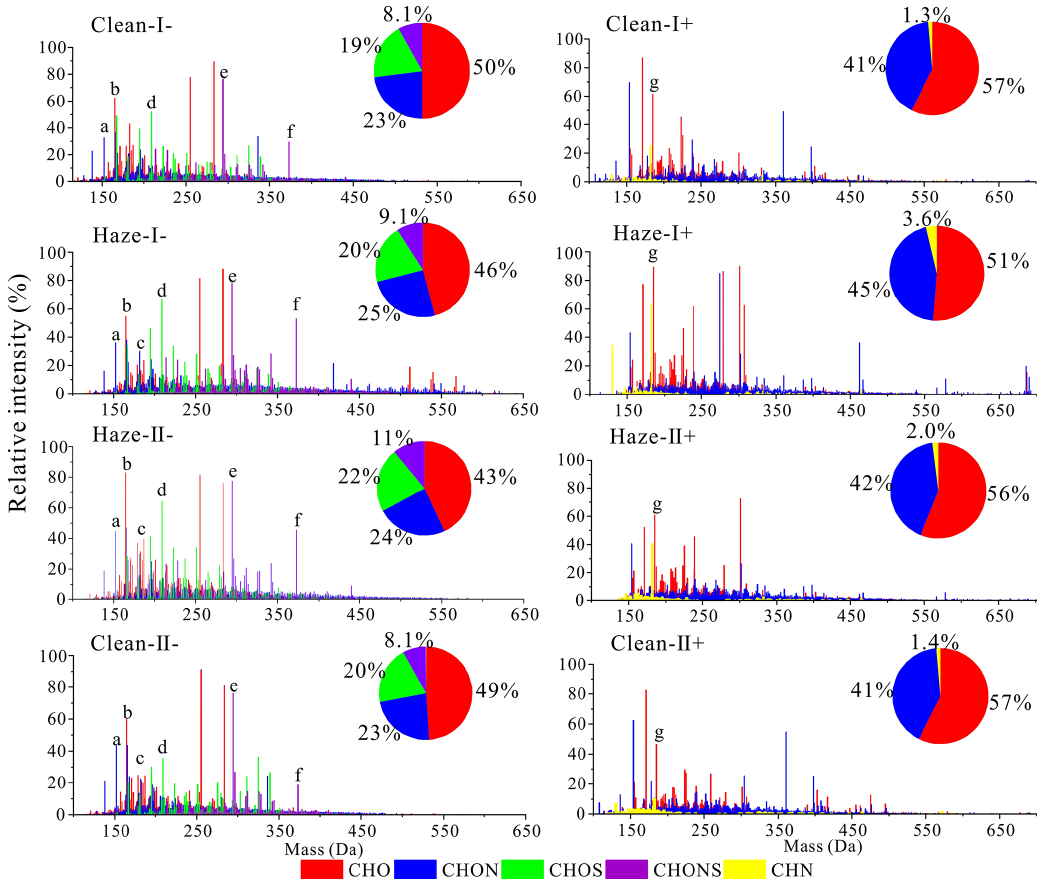
Figure 2. Mass spectra of HULIS detected in ESI − and ESI + modes during the haze process. The pie charts represent the intensity percent of different compound